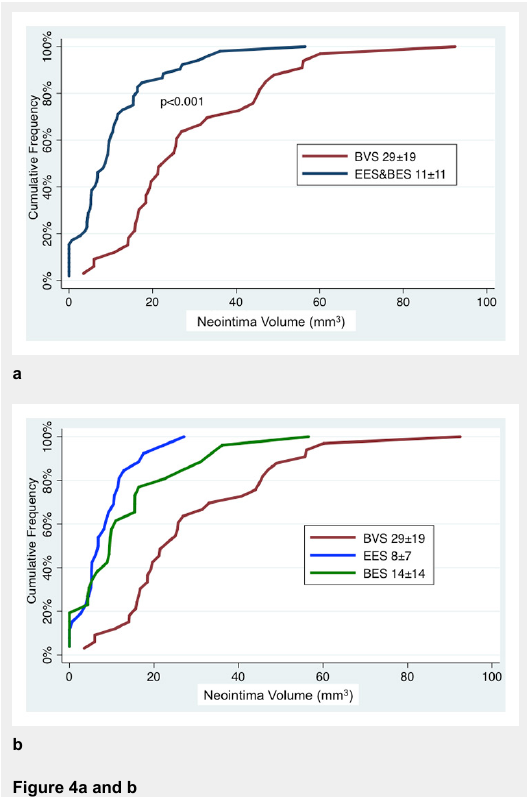
Figure 3a and b Frequency distribution of mean neointima thickness at intervals of 50 µm. BES = biolimus-eluting stent; BVS = bioresorbable vascular scaffold; EES = everolimus-eluting stent.